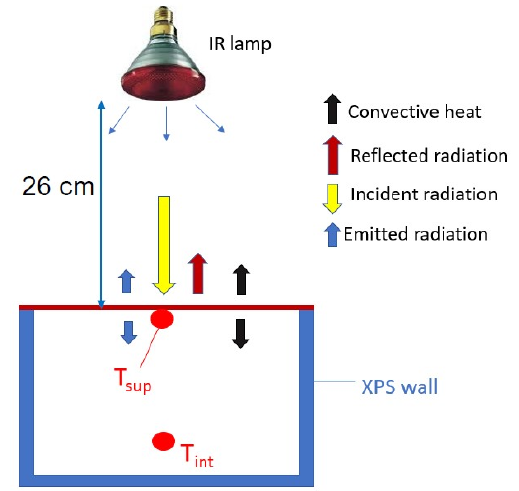
Figure 1. Schematic description of the small-scale houses utilized as support for the roof panels for thermal measurements. The red dots represent the thermocouples that were attached behind the metal sheet and inside the house models at 4 cm from the floor. The thermocouples were connected to a data logger.